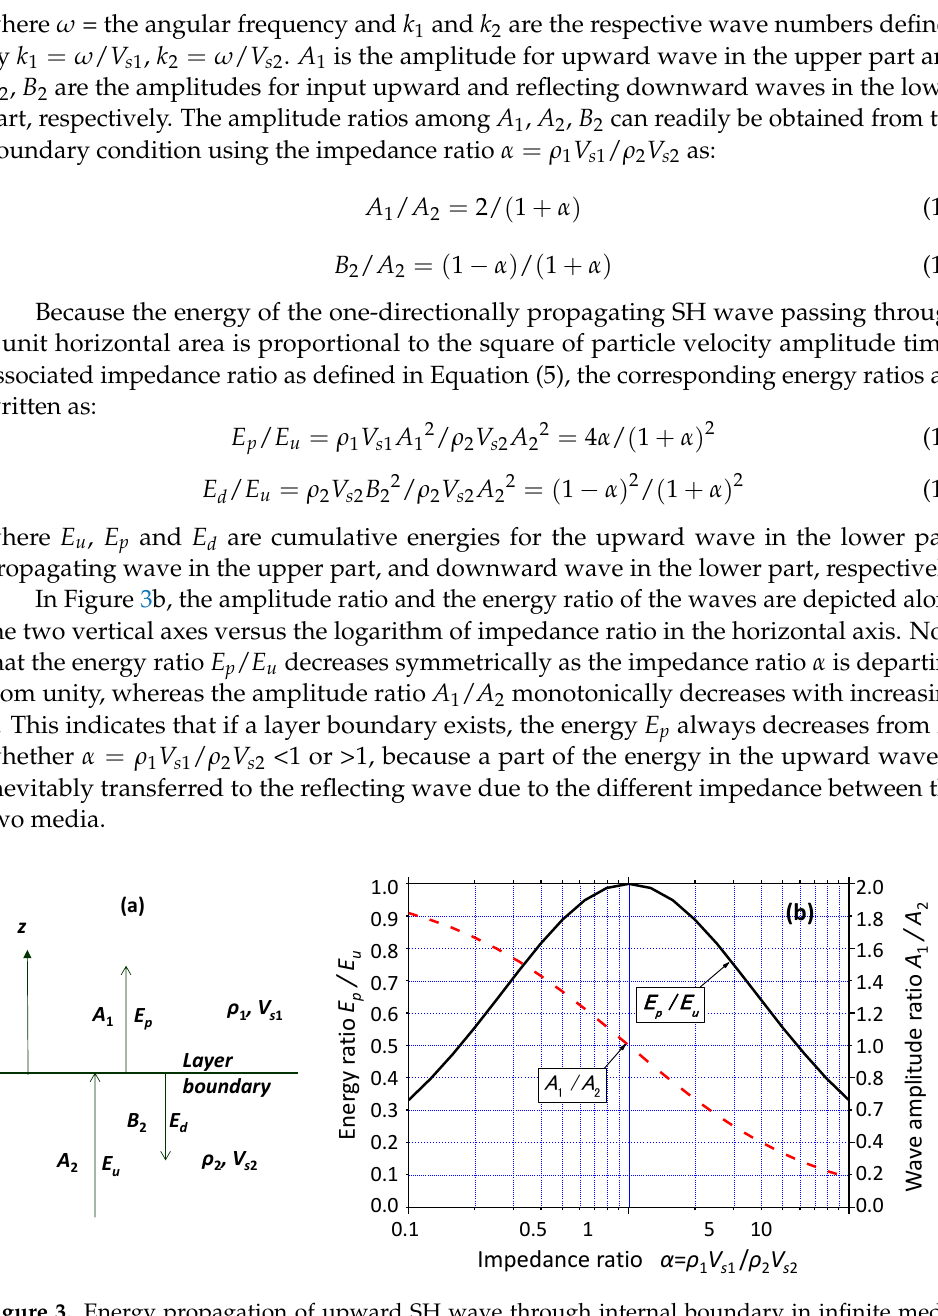
Figure 3. Energy propagation of upward SH wave through internal boundary in infinite media: one- dimensional model ( a ) and energy and amplitude ratio in SH wave propagation ( b ).